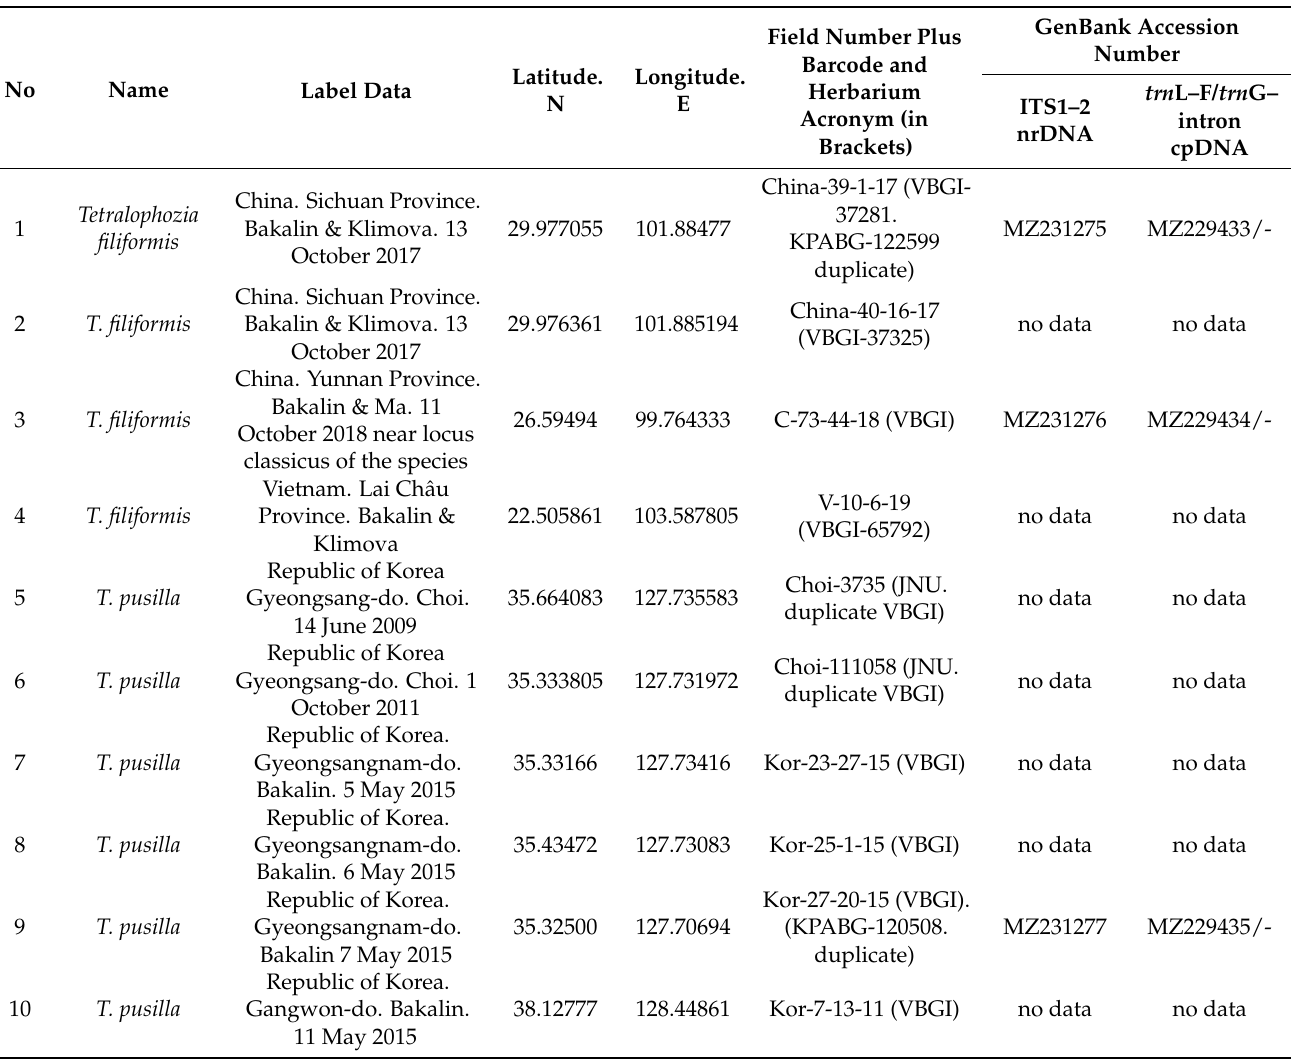
Table 5. Specimens examined (excluding the types of Tetralophozia filiformis (Steph.) Urmi